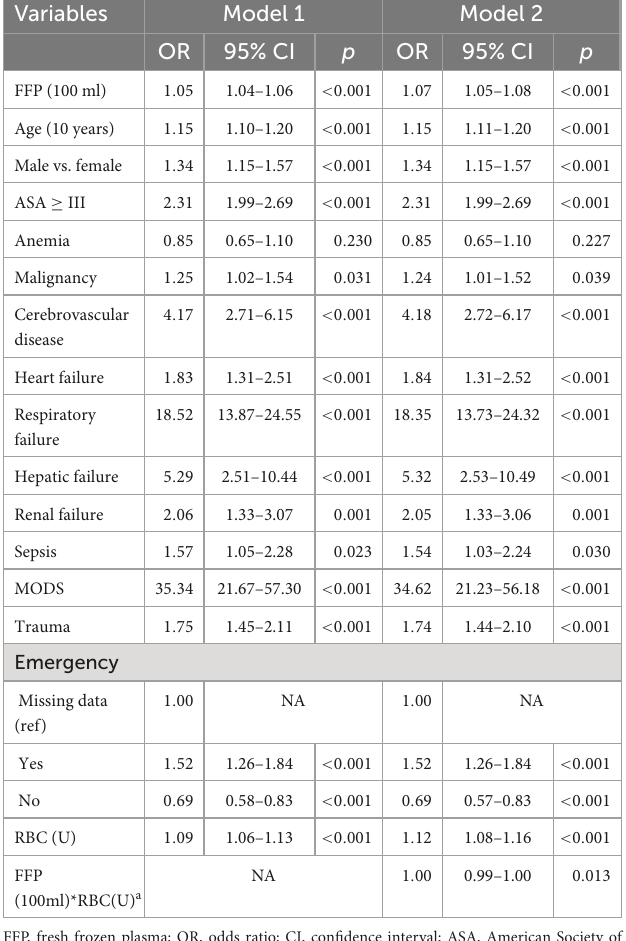
FFP, fresh frozen plasma; OR, odds ratio; CI, confidence interval; ASA, American Society of Anesthesiology; MODS, multiple organ dysfunction syndrome; ref, reference; RBC, red blood cell;U,unit;NA,notapplicable. a